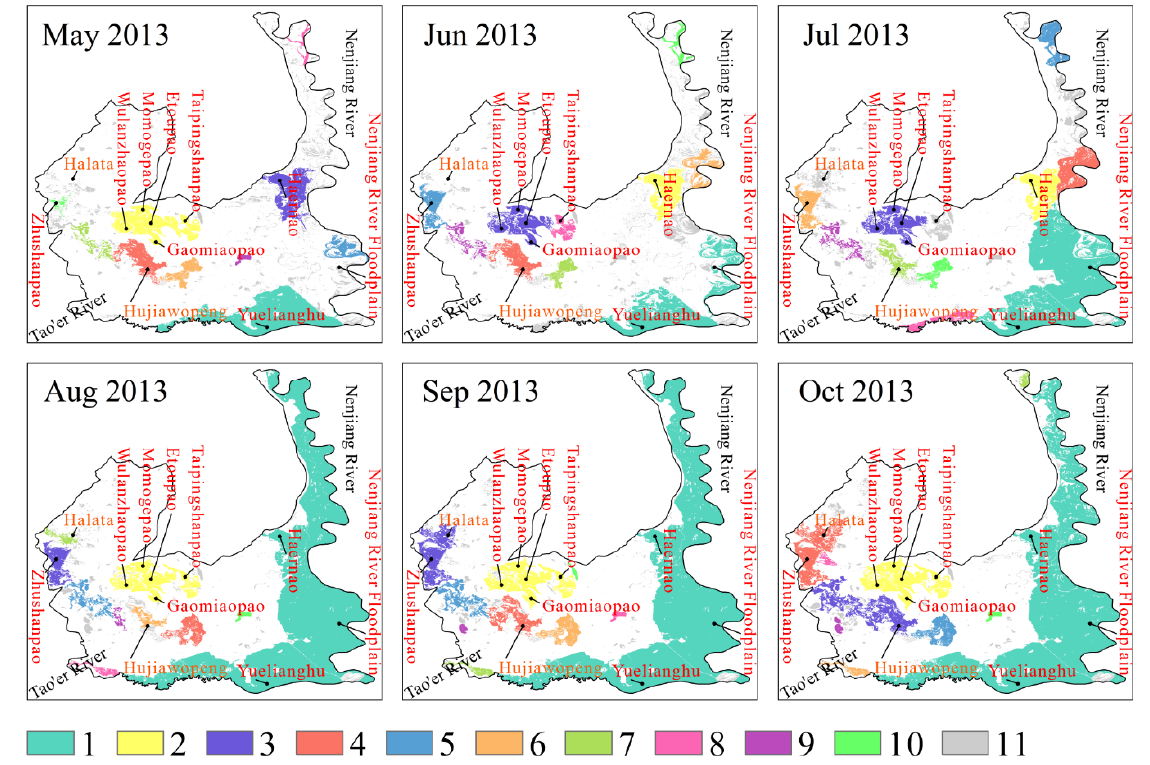
Figure 6. Spatiotemporal distribution of the connectomes in Momoge National Nature Reserve, China during a wet year. Colors 1–10 in the legend refer to the top 10 largest connectomes, and color 11 refers to the remaining connectomes and isolated water bodies. Data source: EC JRC/Google.